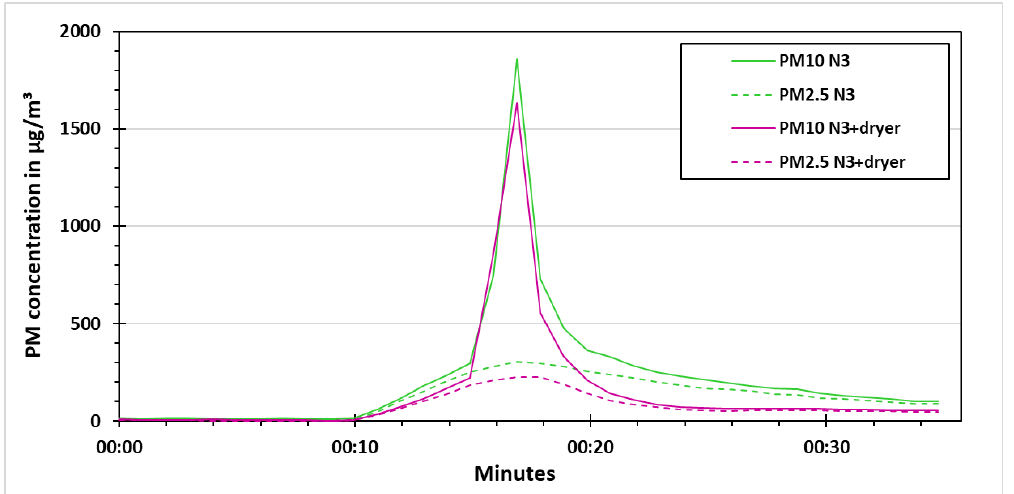
Figure 15. PM concentration for the synthetic dust experiment with vaporizer.